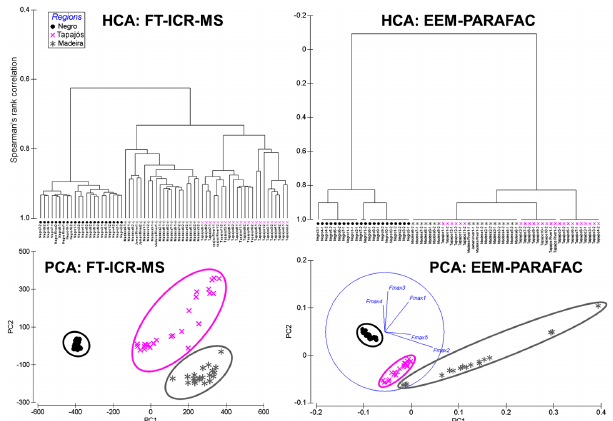
Figure 4. Principal component analysis and hierarchical cluster analysis of the normalized data of all m/z ions and their intensi- ties and all EEM-PARAFAC Fmax